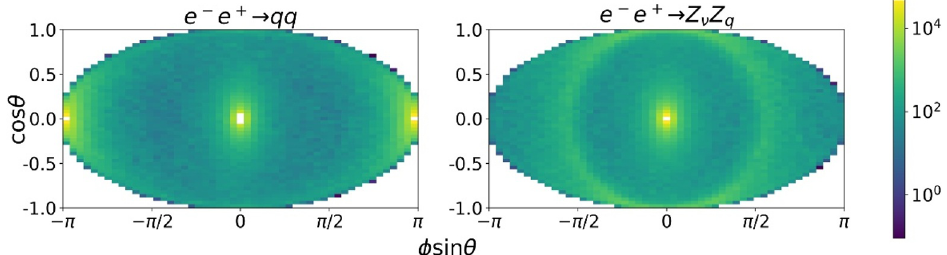
Figure 2 . Cumulative Mollweide projections of 10000 events: qq (left) and Z (cid:23) Z q (right), with the brightness of each cell scaling with the total energy (GeV) of the particle hits